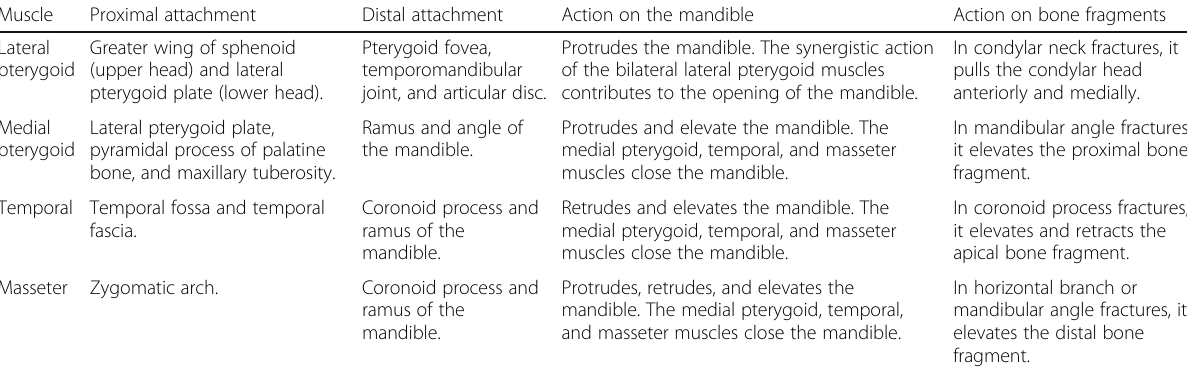
Table 1 Insertion points and actions of the masticatory muscles